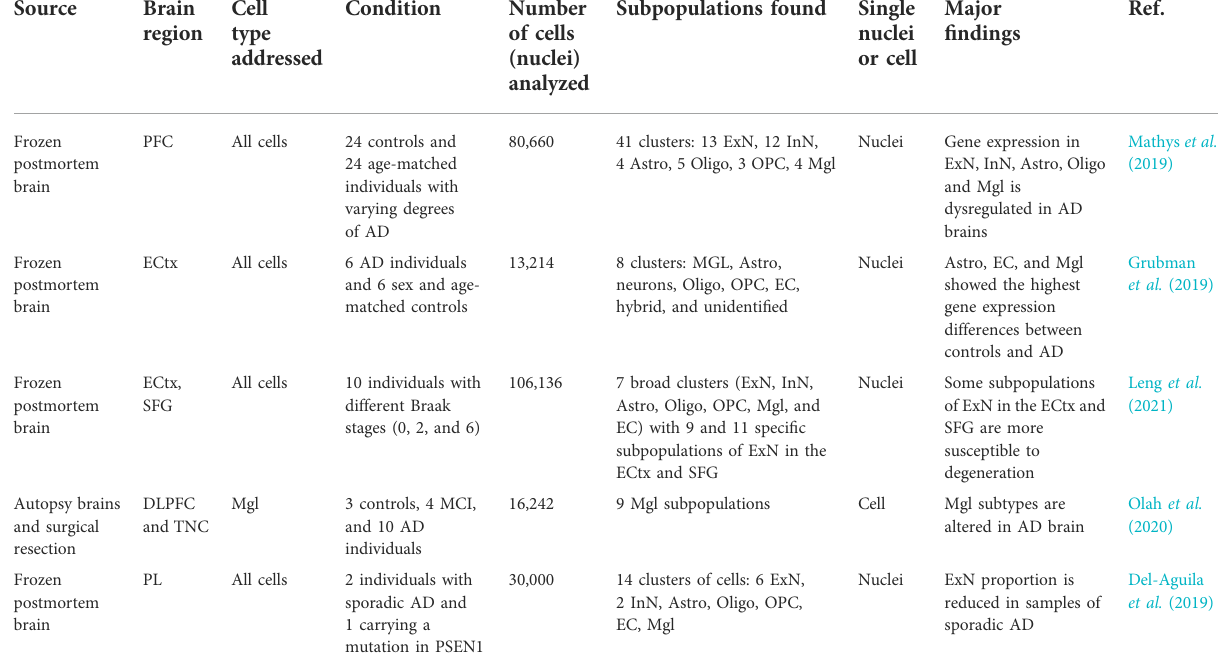
TABLE1SelectedexamplesofrecentscRNA-seqorsnRNA-seqstudiesinAD.Prefrontalcortex(PFC),Entorhinalcortex(ECtx),Dorsolateralprefrontal cortex (DLPFC), temporal neocortex (TNC), parietal lobe (PL), and superior frontal gyrus (SFG). Oligodendrocyte precursor cells (OPC), oligodendrocytes (Oligo), astrocytes (Astro), microglia (Mgl), inhibitory neurons (InN), excitatory neurons (ExN), and endothelial cells